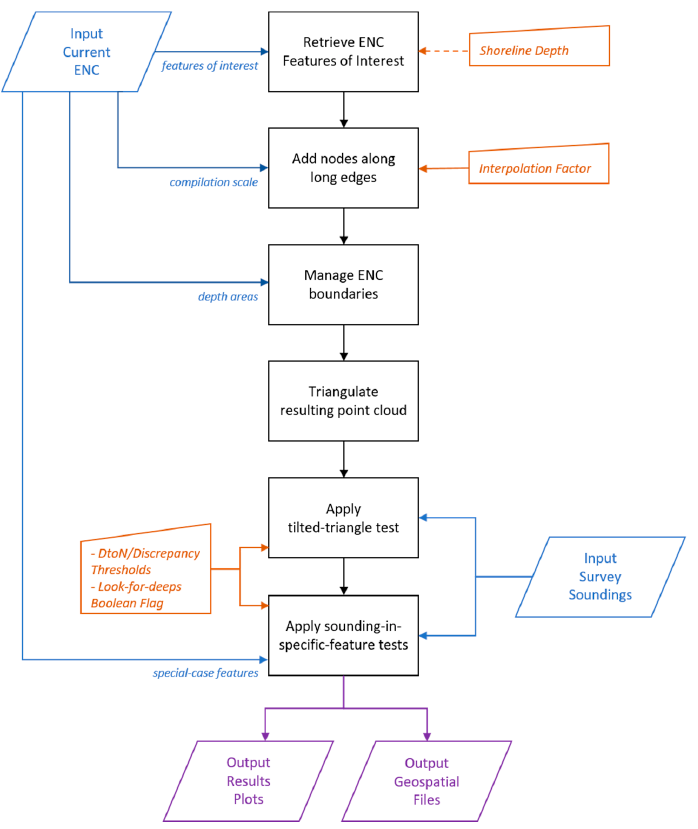
Figure 6. The flowchart shows, in black, the main steps of the proposed algorithm. The inputs are represented in blue, the user parameters in orange (with a dashed connector when optional), and the outputs in purple.